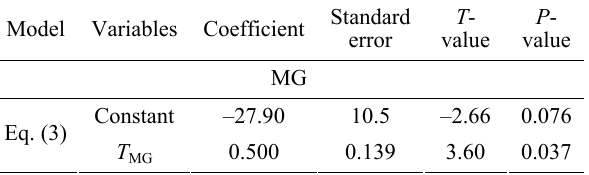
Table 6 Statistical analysis results of the significant regression models.